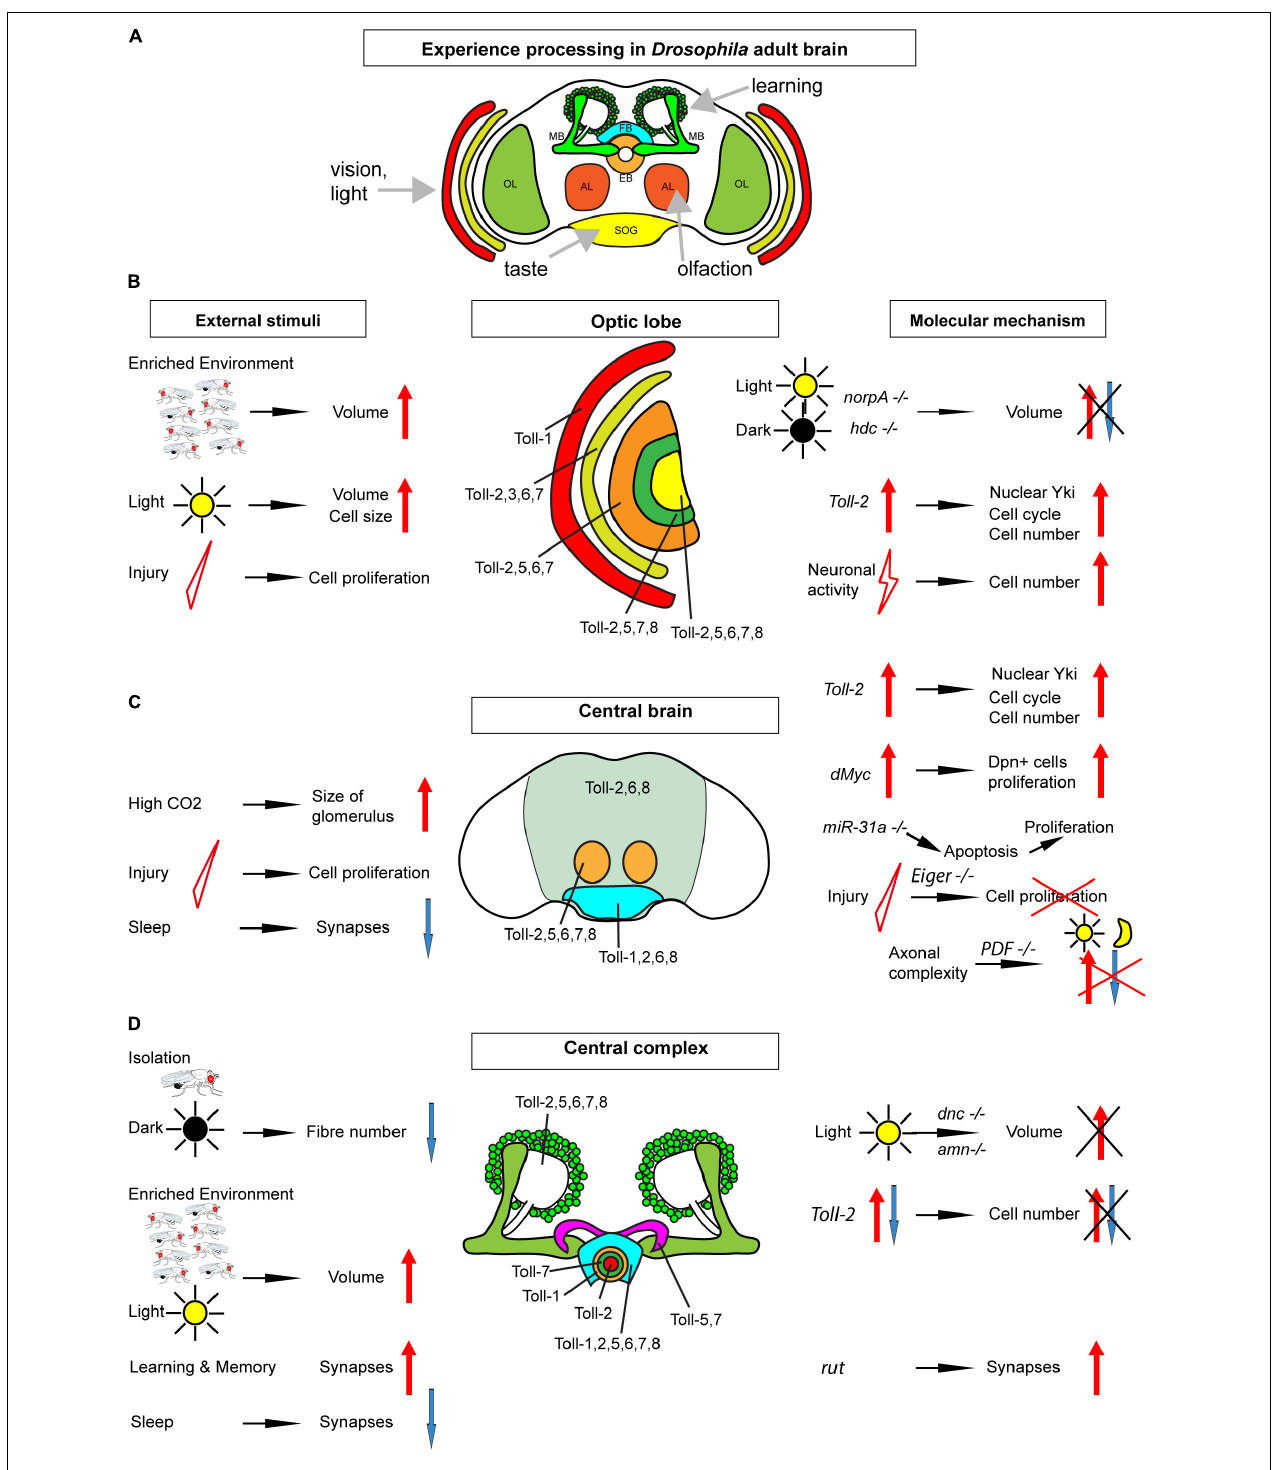
FIGURE 1 | Map of Toll receptors in a Drosophila adult brain. (A) Drosophila adult brain illustrating some modules receiving sensory input and involved in learning. (B) Optic lobe (including retina, lamina, medulla, lobula, and lobula plate from outer to inner layers). (C) Central brain [including neuropiles (pale green), antennal lobes (orange), and sub-esophageal ganglion (bright blue)]. (D) Central complex: mushroom bodies (green) ellipsoid body in rings, fan-shaped body (bright blue), and protocerebral bridge (purple). Each brain module expresses different Tolls or a combination of Tolls; thus, they could be regulated differentially in distinct brain modules. From (B–D) , the key findings involved in structural brain plasticity are summarized with external stimuli on the left and molecular manipulations and mechanisms on the right. OL, optic lobe; MB, mushroom body; FB, fan-shaped body; EB, ellipsoid body; AL, antennal lobe; SOG, sub-esophageal ganglion.